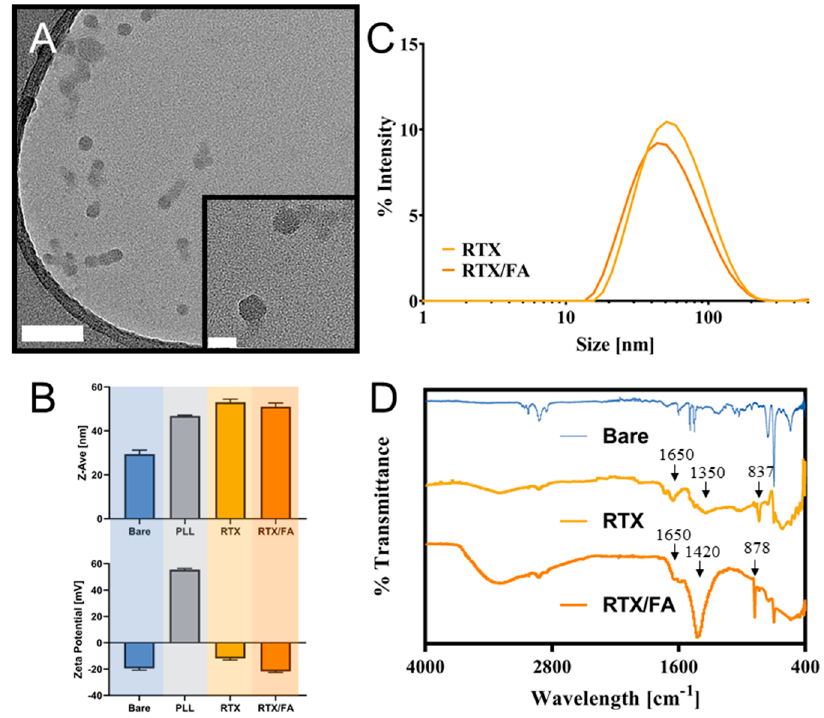
Figure 2. Characterization of RTX and RTX/FA NP formulations. ( A ) TEM images of formed RTX/FA NPs. Scale bar in lower magnification (larger image)—100 nm, scale bar in higher magnification image (inset)—20 nm. ( B ) Intensity derived distribution for the formed NPs as measured by dynamic light scattering (DLS). ( C ) Mean size and zeta-potential measurements at each step in the layering process shows increase in size during synthesis, and accompanying alternating charge. ( D ) IR spectra for the formulated NPs.